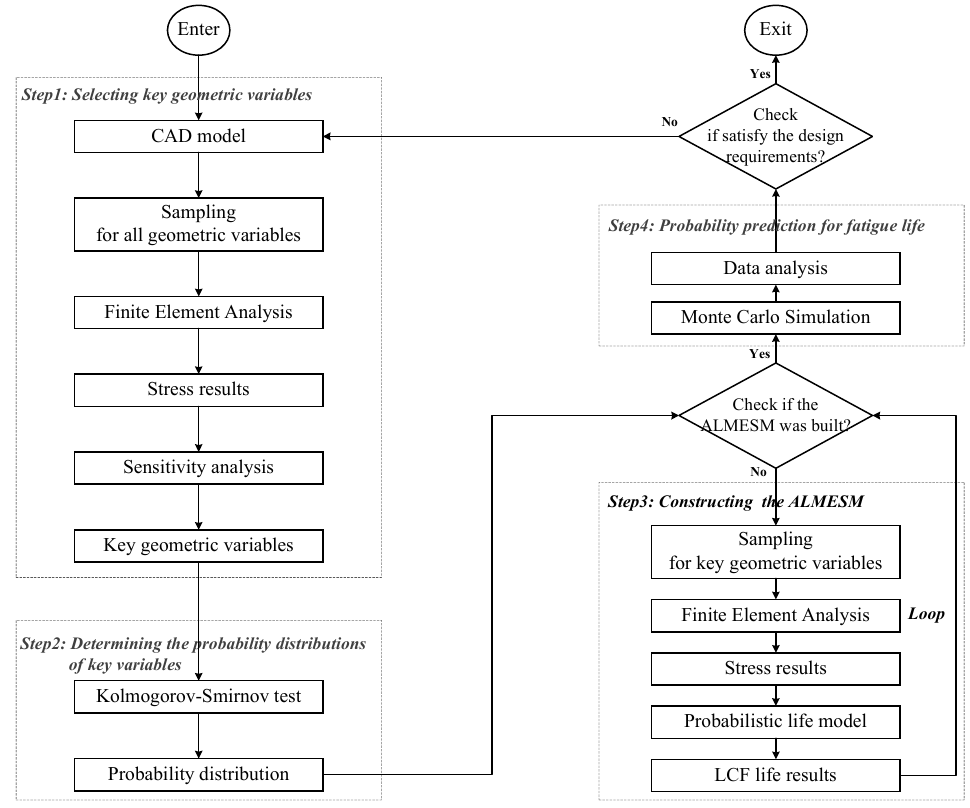
Figure 10. Flow chart for the reliability analysis of a turbine disk considering geometric uncertainties in the Turbine Disk Reliability Analysis (TDRA).